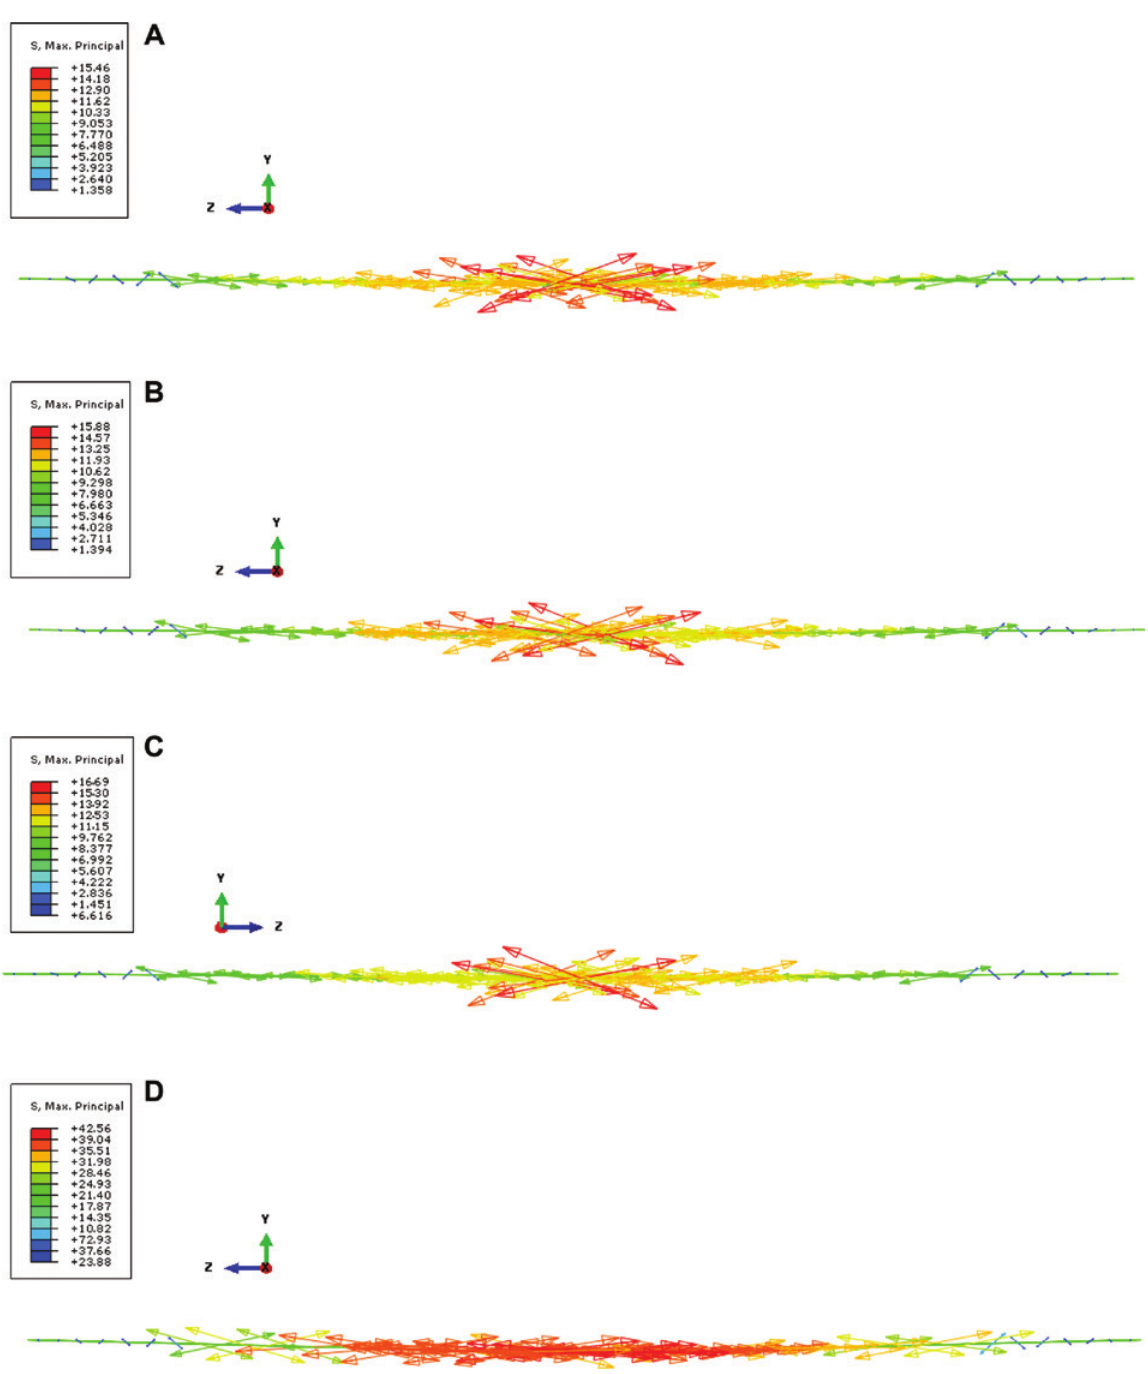
Figure 25: Illustration depicting the magnitude and direction of the maximum principal stresses along middle row of elements in the adhe- sive layer of a CFRP-retrofitted RC beam after the (A) 10,000 th cycle, (B) 30,000 th cycle, (C) 50,000 th cycle, and (D) last cycle. N . Stress contour values are in 2